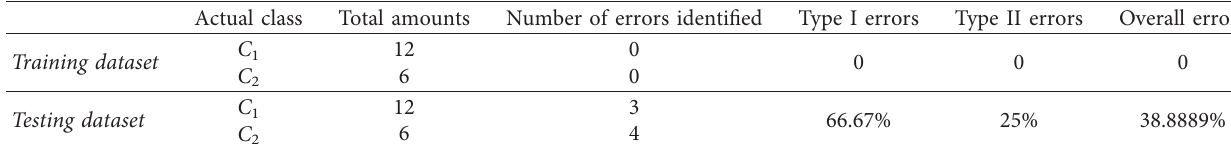
Table 8: Error summary using single UTADIS method.